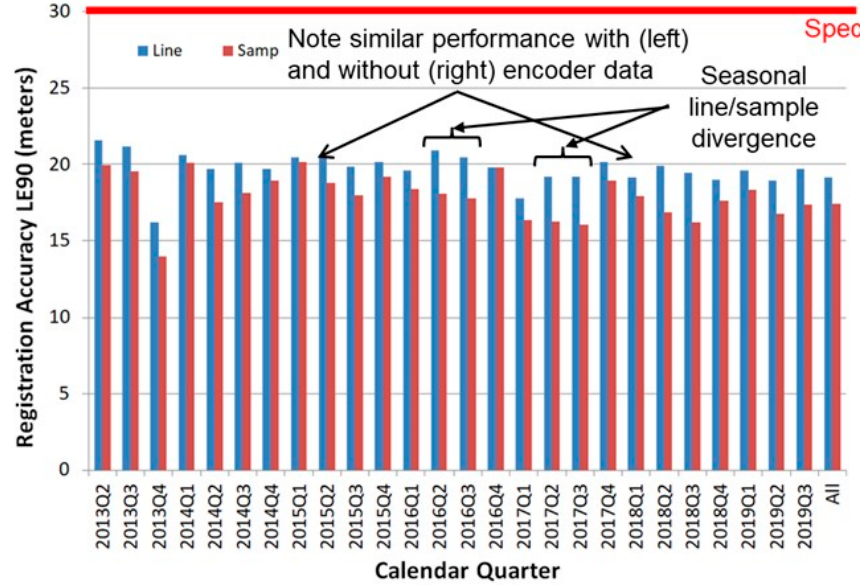
Figure 11. TIRS-to-OLI alignment accuracy is shown broken out by quarters within a calendar year. Seasonal dependencies are pointed to within the figure, as is the demonstration of the accu- racy being equivalent once an SSM mode-0 event closes out as compared to the early in mission mode-4 operations of the